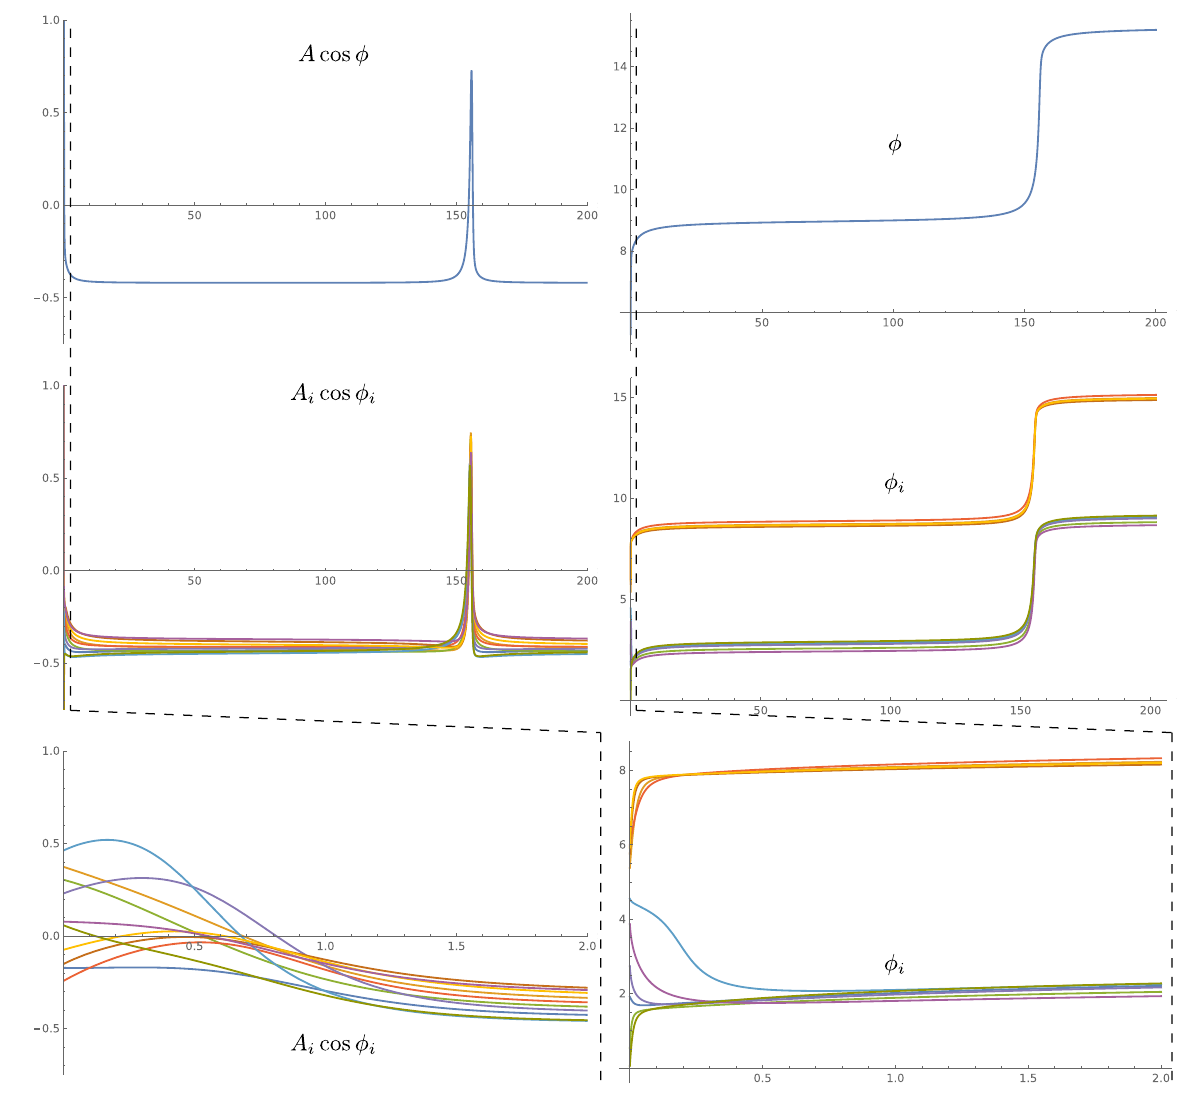
Figure 3. (Top) The amplitude and phase of a single mode spiking in a close to critical regime. (Middle) The spiking of multiple modes with different linear frequencies ω i critically synchronized at the same effective spiking frequency that is close to critical frequency (the units are arbitrary). Similar to subcritical spiking in Fig. 2, the details of wavefront shapes for each mode are different, but the spiking synchronization between modes is very strong and precise. (Bottom) Expanded view of the initial part of the amplitude and phase of the mode shows the efficiency of synchronization–synchronization